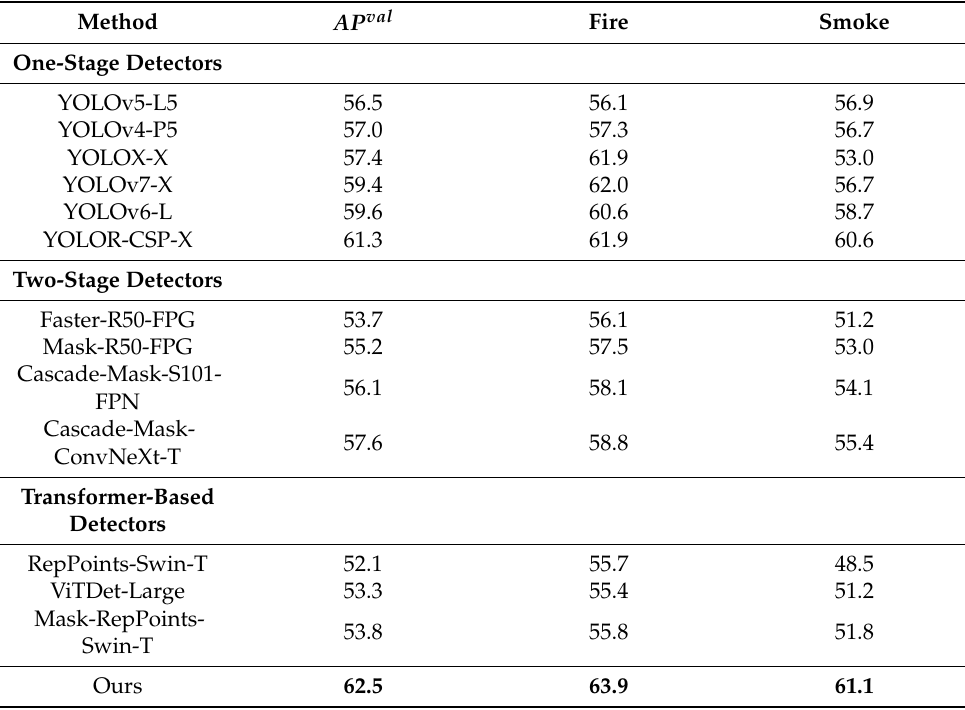
Table 5. Fire and smoke object detection